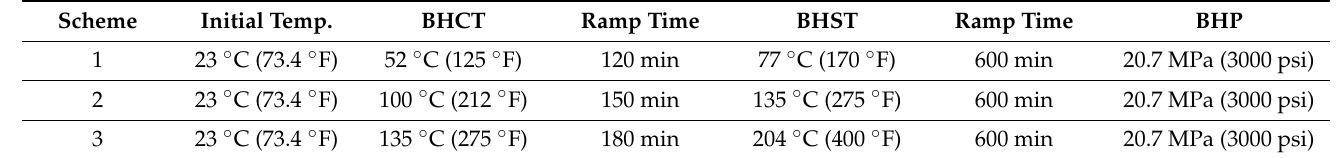
Table 3. Curing parameters for the three curing schemes used in this study. Scheme Initial